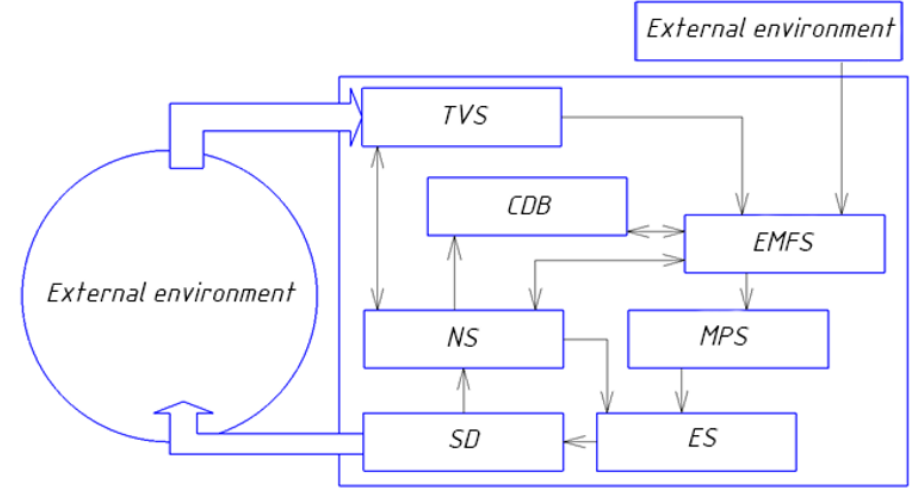
Fig. 1. The structural diagram of the